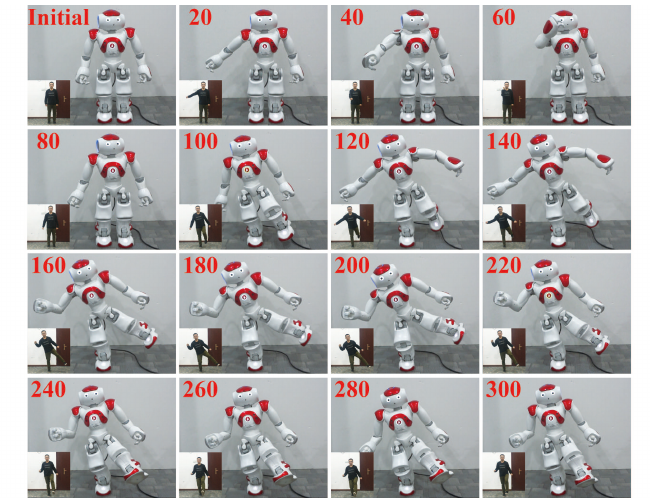
Figure 10. Snapshots of the robot and the human demonstrator in the first experiment. The red numbers are the ordinal numbers of the motion loops, of which the average duration is 0.26